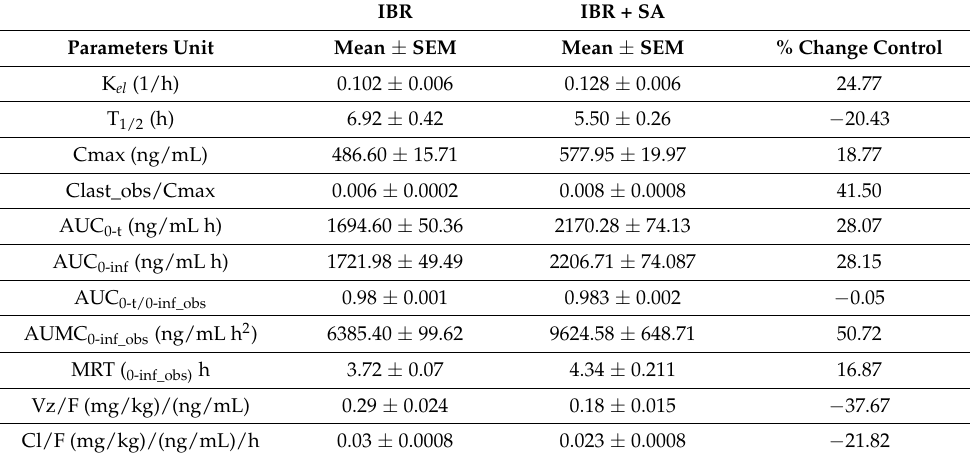
Figure 1. Plasma concentration versus time profile of IBR alone and with SA after oral administra- tion in rats ( n = 6).